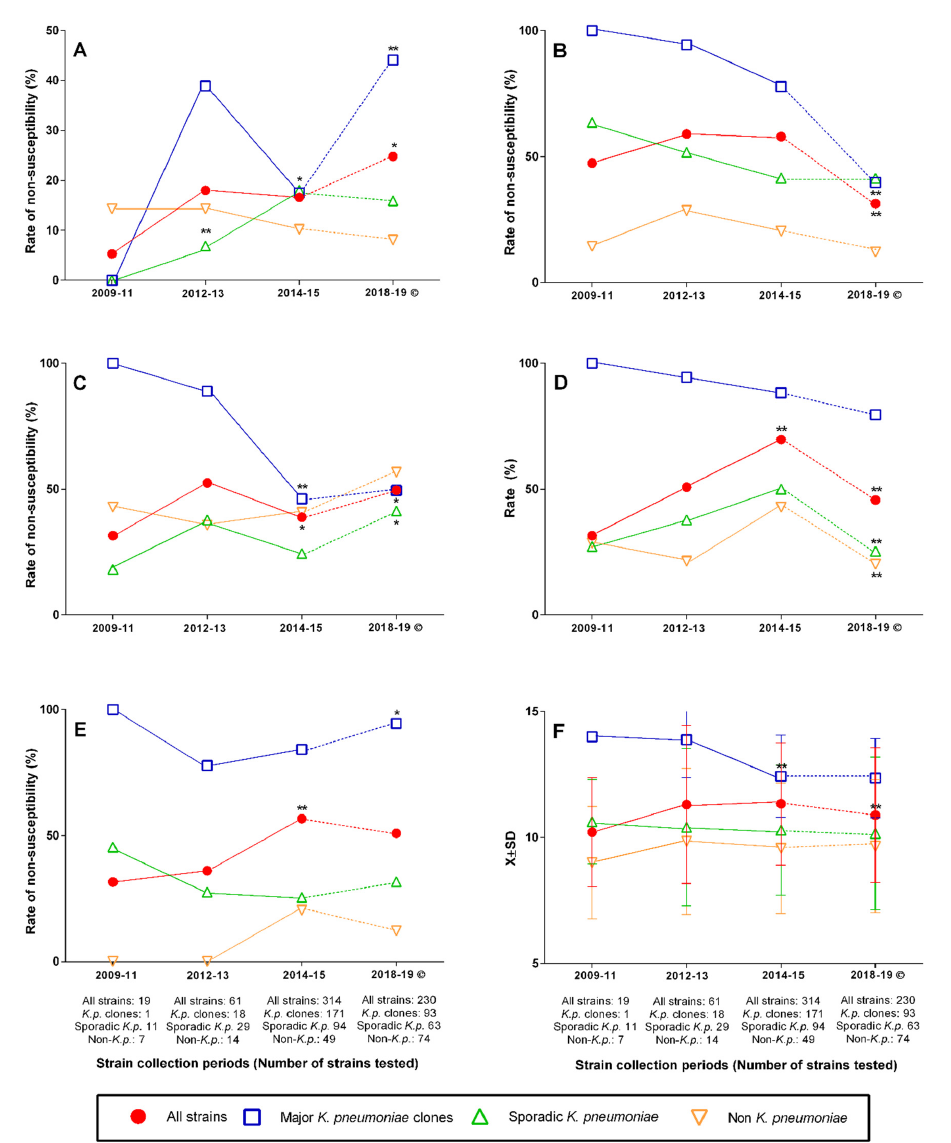
Figure 3. Changing rates of selected antibiotic resistance parameters over time. ( A ) Colistin, ( B ) tigecycline, ( C ) ceftazidime–avibactam, ( D ) meropenem MIC > 8 mg/L, ( E ) amikacin, and ( F ) R index. Continuous line: current study period; dashed line: changes until the most recent data © [20]. * Significantly ( p < 0.05); ** Highly significantly ( p < 0.01) different from the previous point of time.